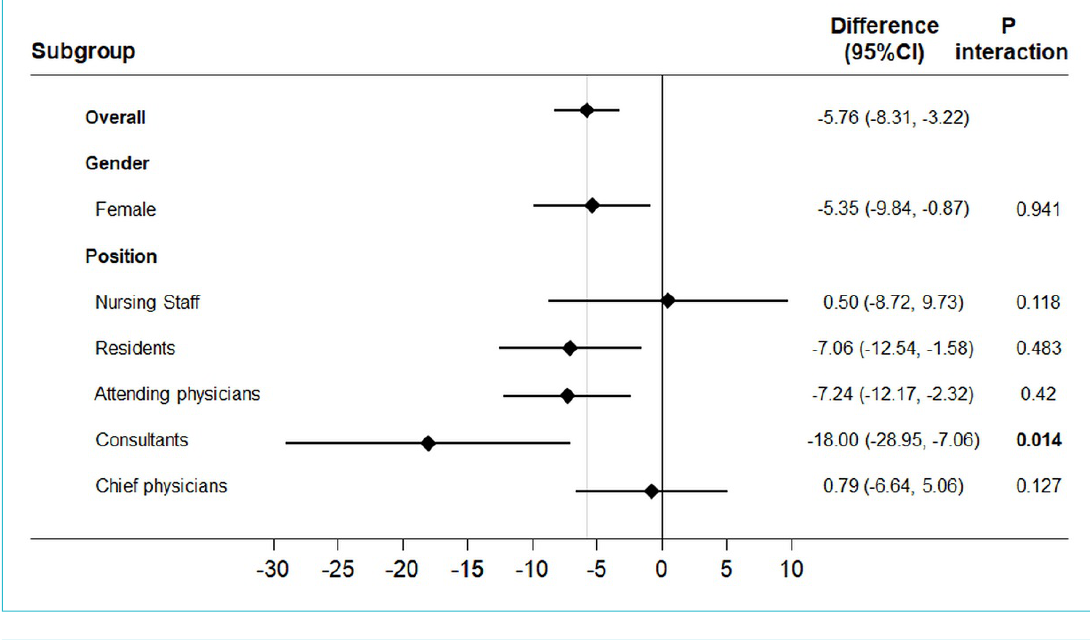
Figure S1: “Having sufficient time for ward round” in different subgroups . All differences calculated with multivariate linear regression models for continuous data.